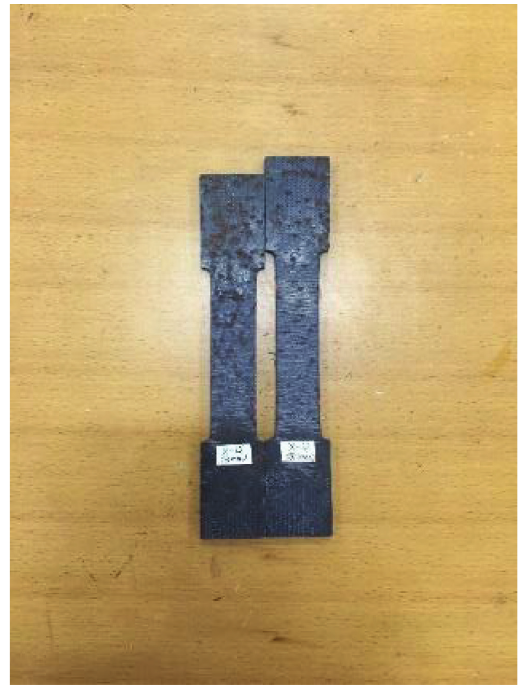
Figure 3: Contrast of elongation (initial elongation is 3mm and 8.4 mm).